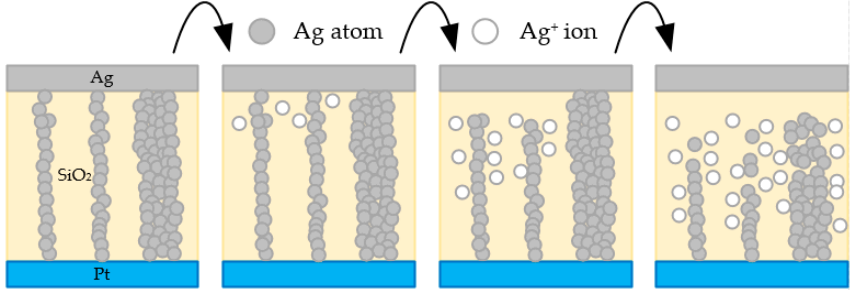
Figure 5. Illustration of multilevel RESET process of Ag/SiO 2 /Pt RRAM device.